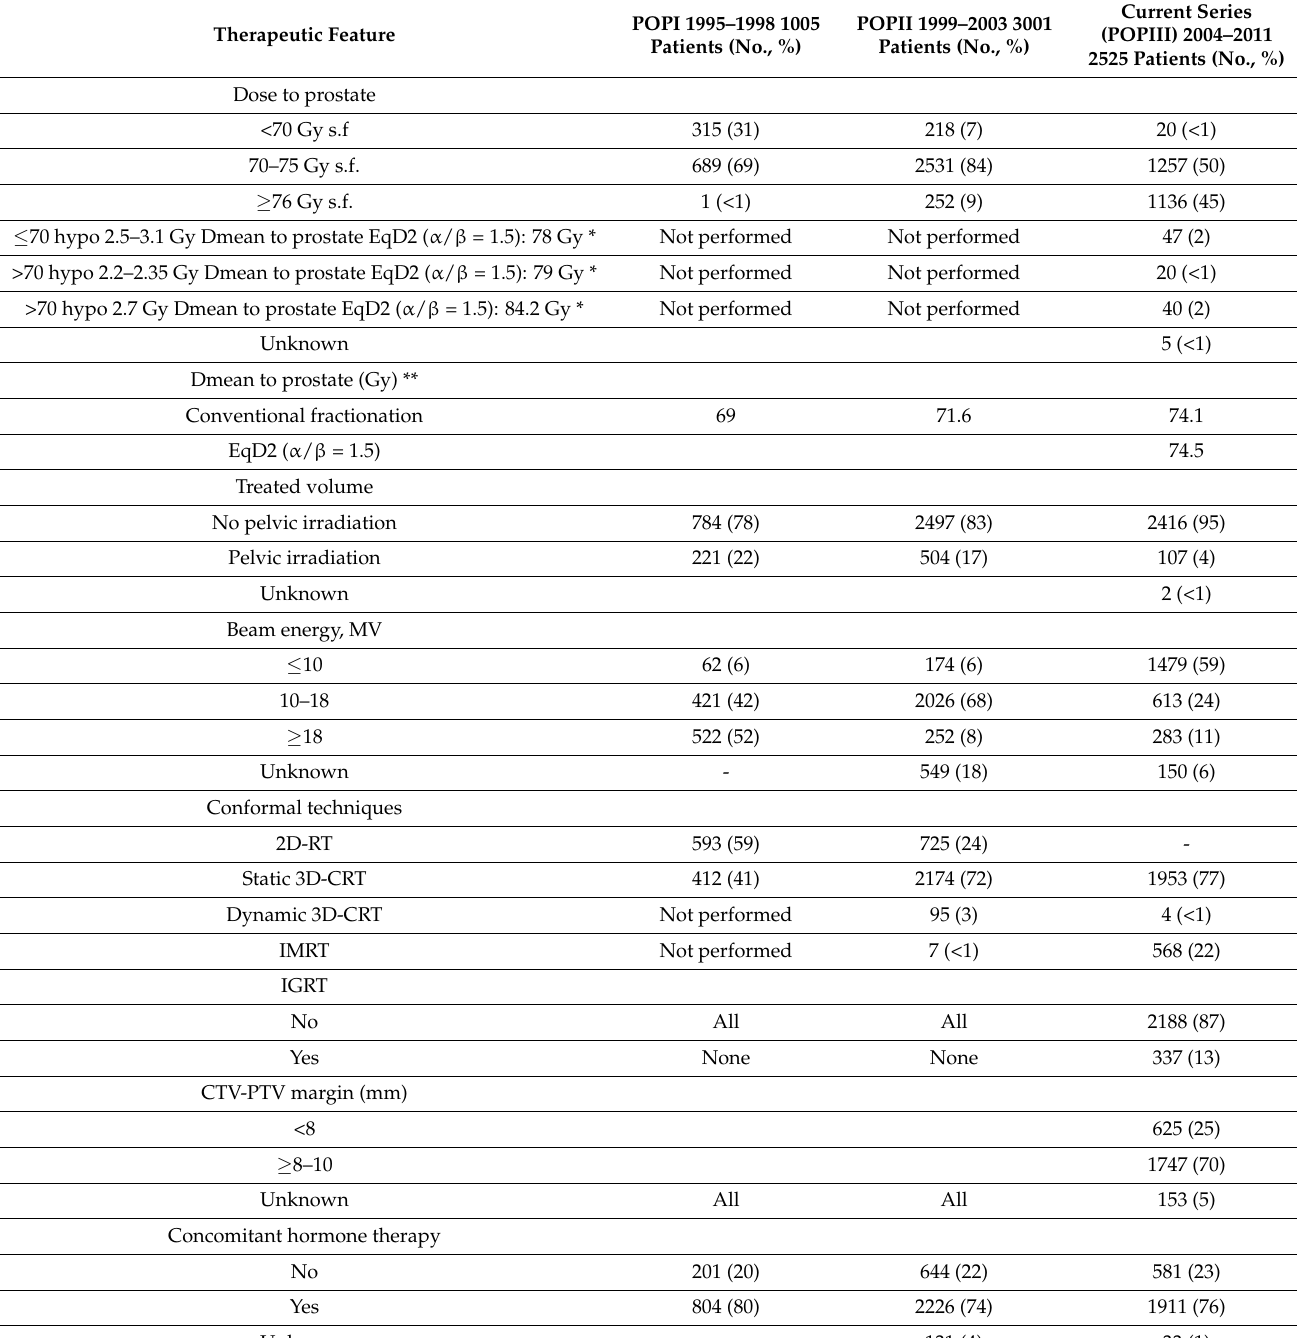
Table 3. Therapeutic procedures adopted in the three subsequent